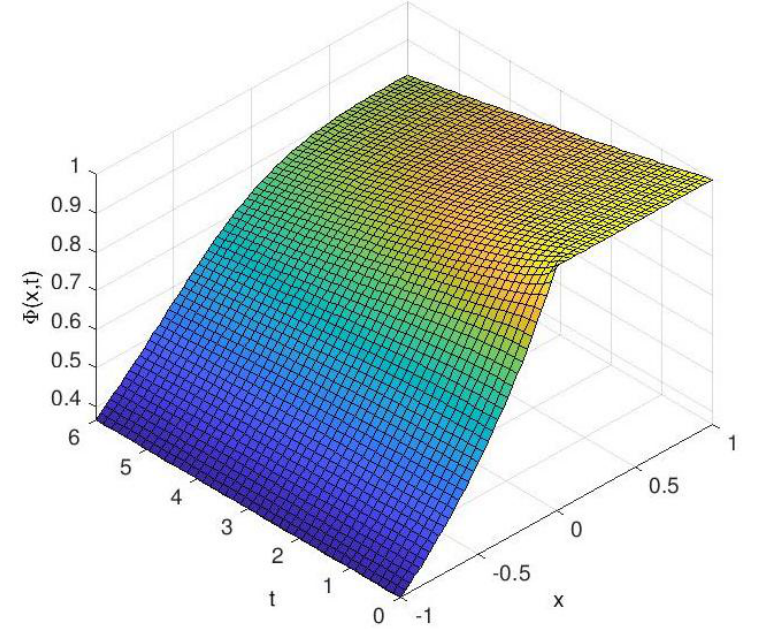
Figure 1. Bond-Value Function Φ vs. firm’s log value x and time t when fixed interest rate r